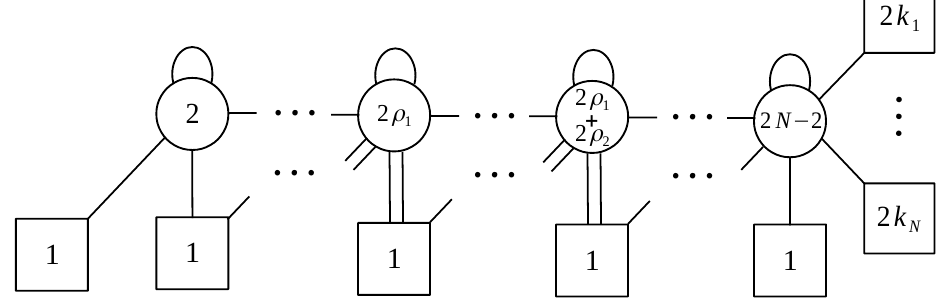
Figure 16 . The quiver diagram representation of the deformed theory T . We have double lines in the saw only for the gauge nodes at positions (cid:26) 1 ; (cid:26) 1 + (cid:26) 2 ; : : : ; P N (cid:0) 1 theory, which is denoted by T _ , has the same diagram with (cid:26) and (cid:27) exchanged.